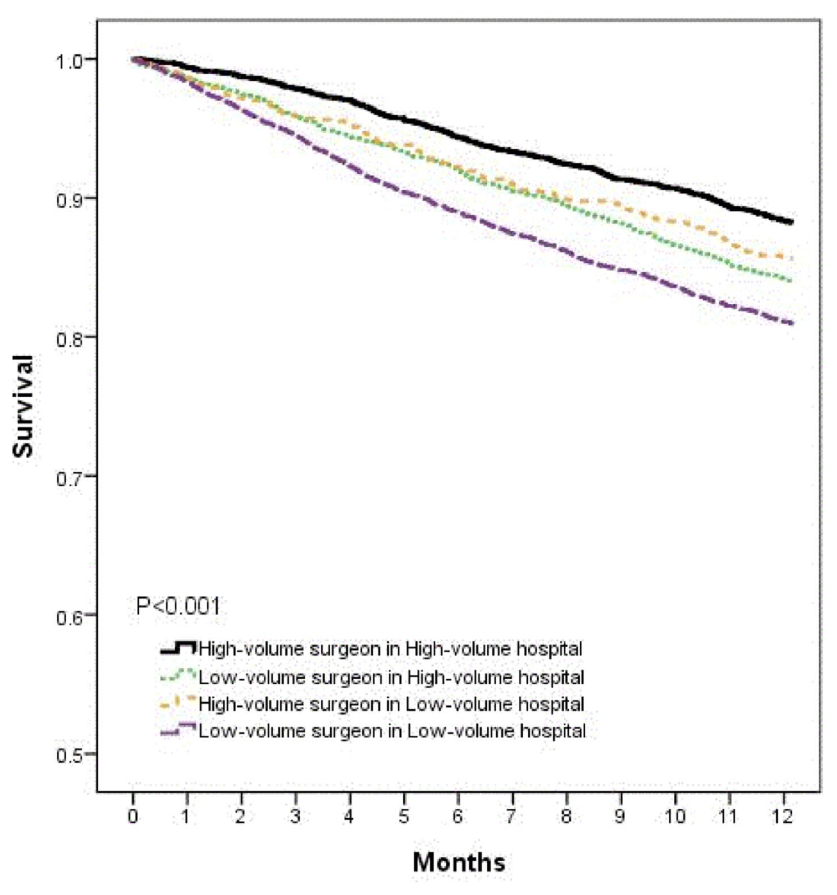
Figure 1. Short-term survival after hepatic resection by combined effect of surgeon and hospital volume.